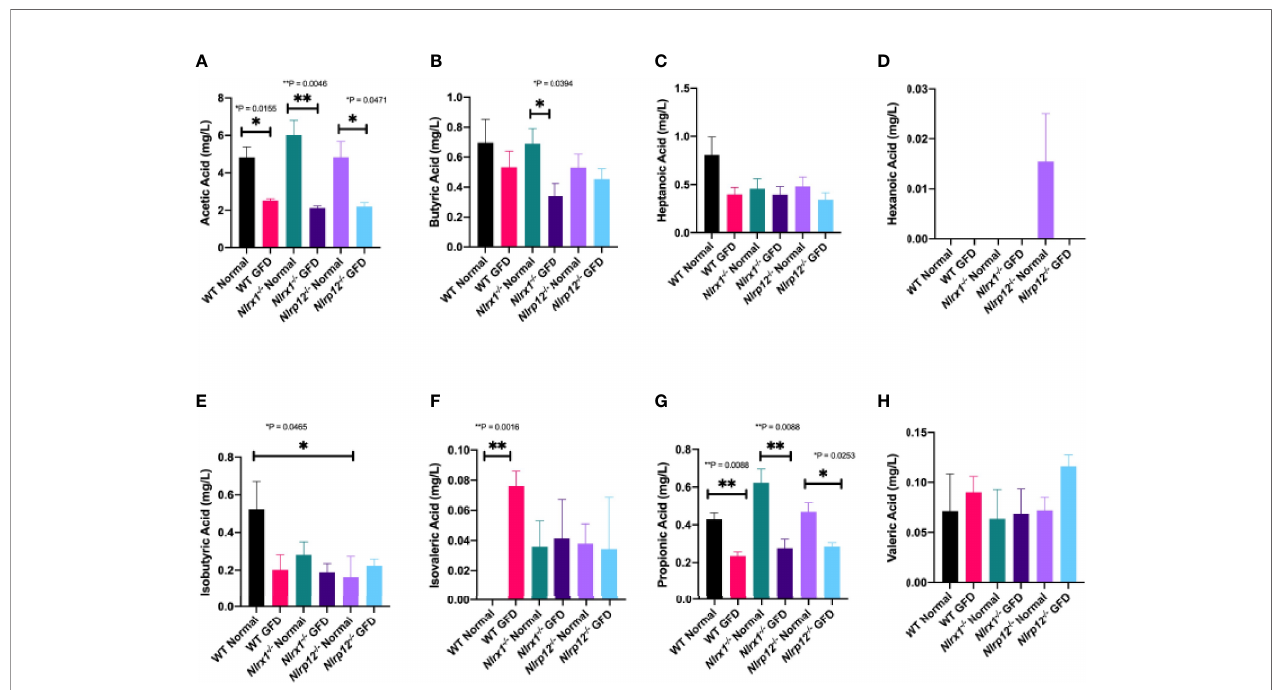
FIGURE 8 | SCFA and MCFA Levels Signi fi cantly Vary Based on Diet. Abundance of the (A) acetic acid, (B) butyric acid, (C) heptanoic acid, (D) hexanoic acid, (E) isobutyric acid, (F) isovaleric acid, (G) propionic acid, and (H) valeric acid in mg/L offeces in wild-type, Nlrx1 -/- , and Nlrp12 -/- mice . n = 3-7. * p < 0.05, ** p <